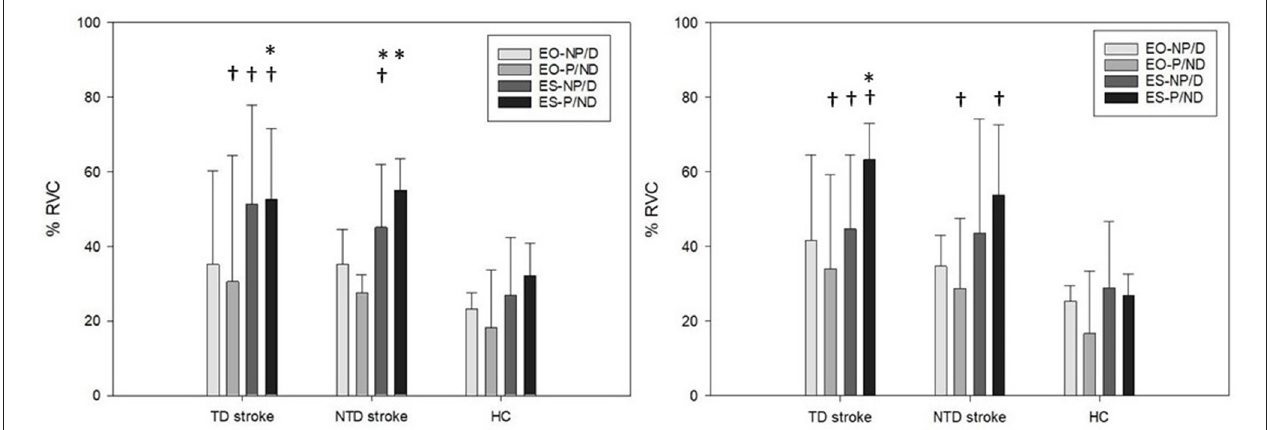
FIGURE 3 | Bilateral external oblique and erector spinae muscles amplitudes (% RVC) for stroke participants with and without turning difficulties and healthy controls during 90 ◦ standing turns toward paretic (left) and non-paretic sides (right). EO, external oblique muscle; ES, erector spinae; TD, turning difficulty; NTD, no turning difficulty; P, paretic side; NP, non-paretic side; HC, healthy control. *represents a significant difference compared with EO. † represents a significant difference compared with